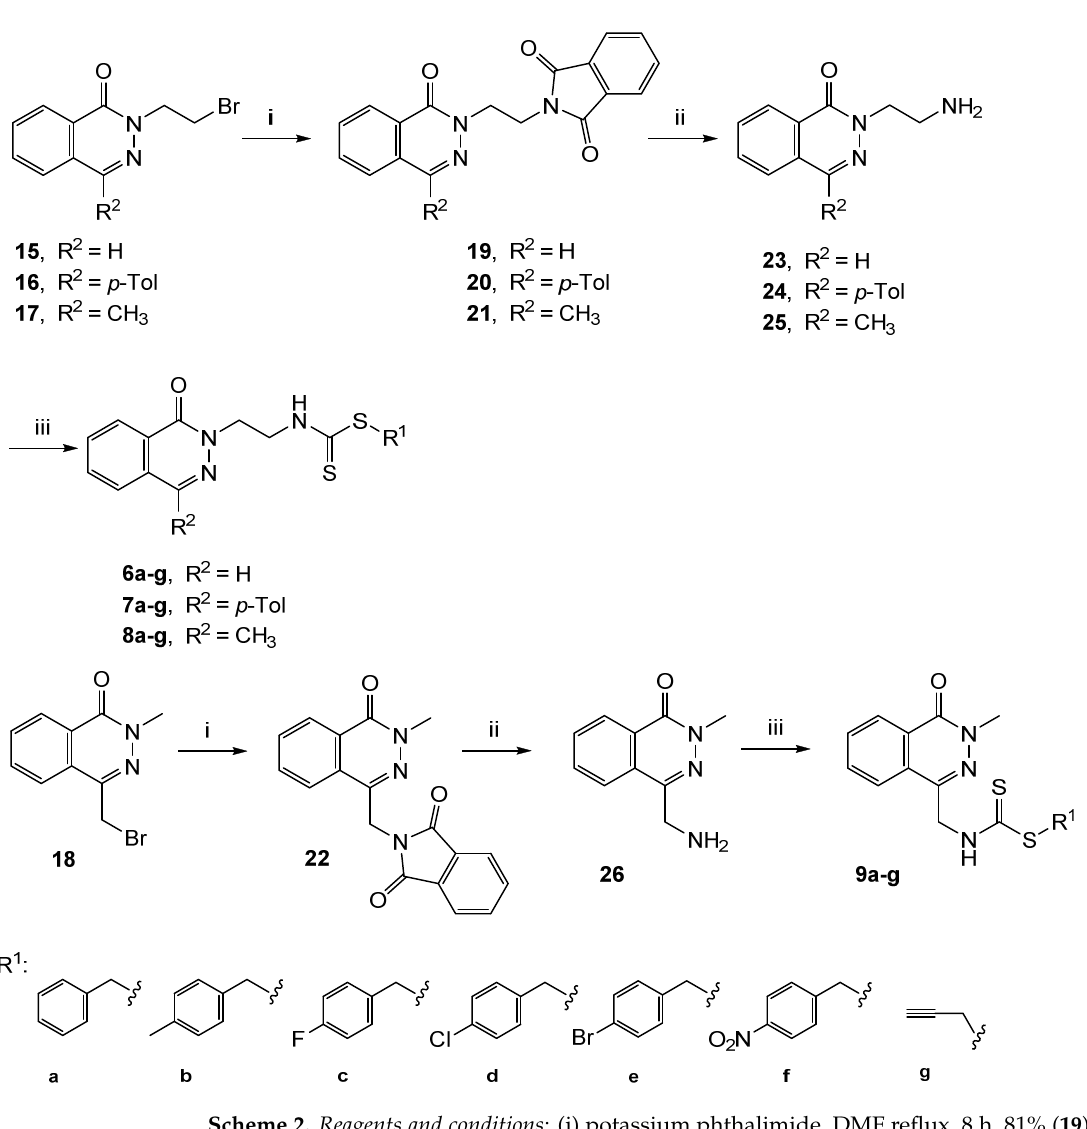
Scheme 1. Reagents and conditions : (i) hydrazine hydrate or methyl hydrazine, ethanol reflux, 5